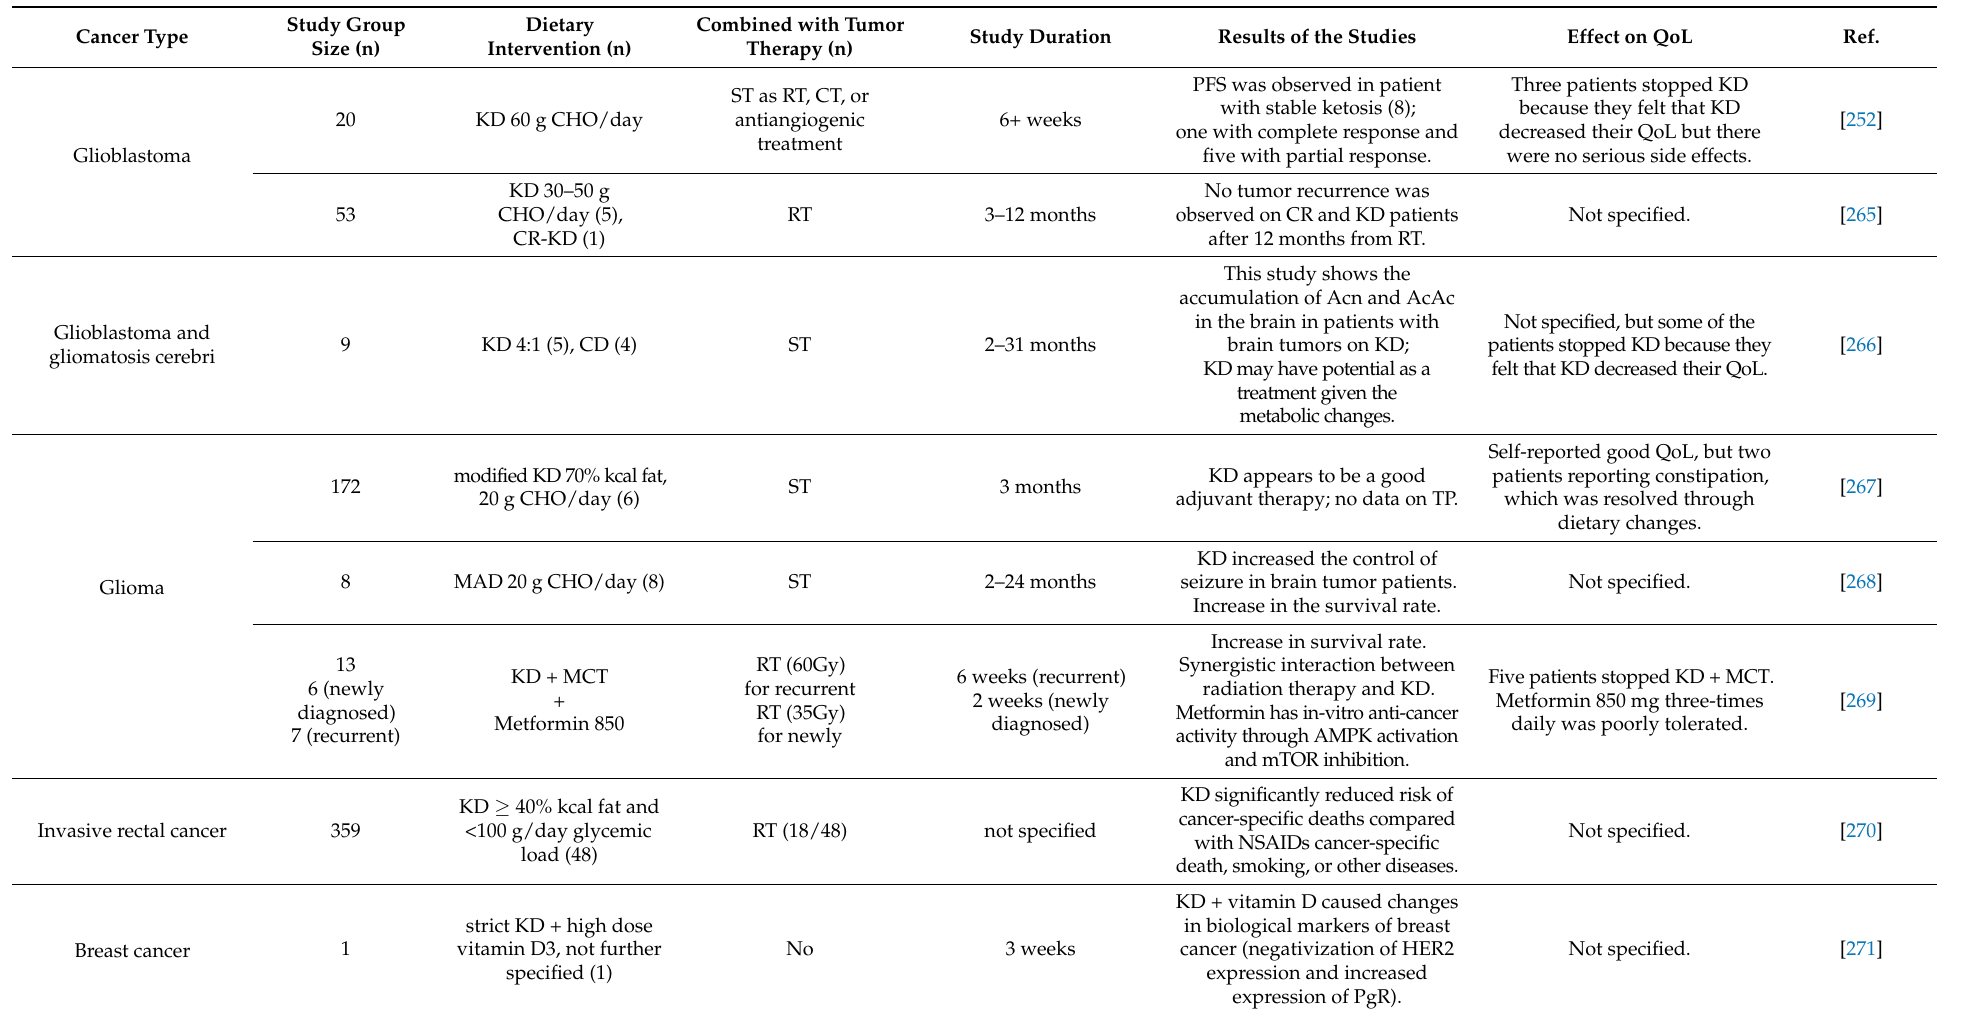
Table 3. Some of the clinical studies for the effect of ketogenic diet on cancer (tumor)